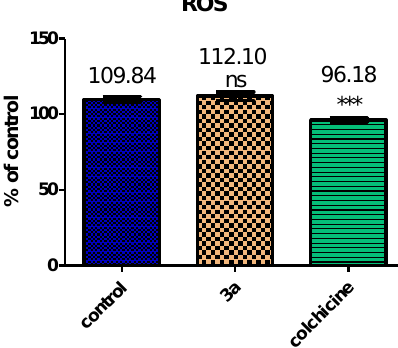
Figure 13. Mitochondrial production of ROS in SR cells with 3a and colchicine reference compared to control. Mean ± standard deviation plotted for three replicates per condition. Results are significantly different from control at *** p < 0.05. The substrate was incubated for 30 min at 37 °C protected from light.